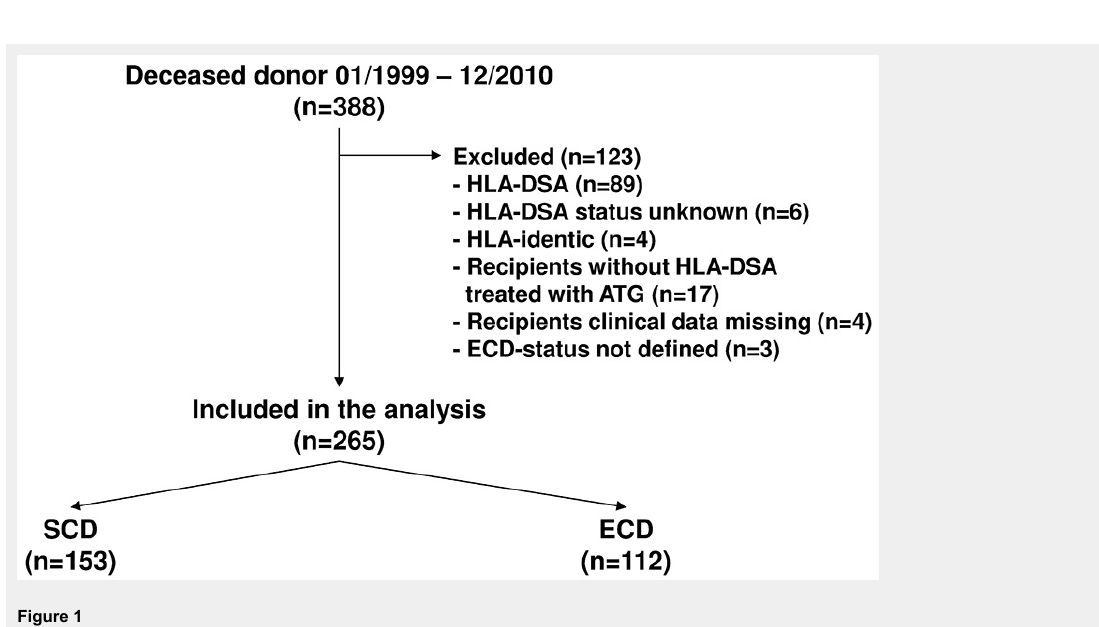
Figure 1 Study flow. ATG = anti-T-lymphocyte globulin; ECD = expanded-criteria donor; HLA-DSA = donor-specific HLA-antibodies; SCD = standard-criteria